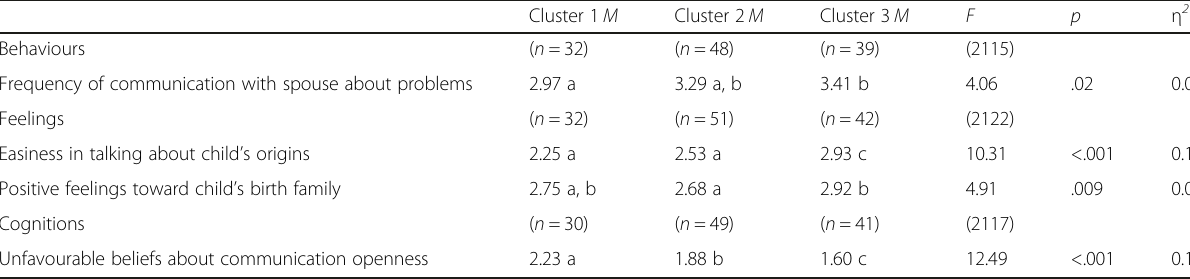
Table 3 Clusters of Adoption Communication and Parenting – ANOVAs